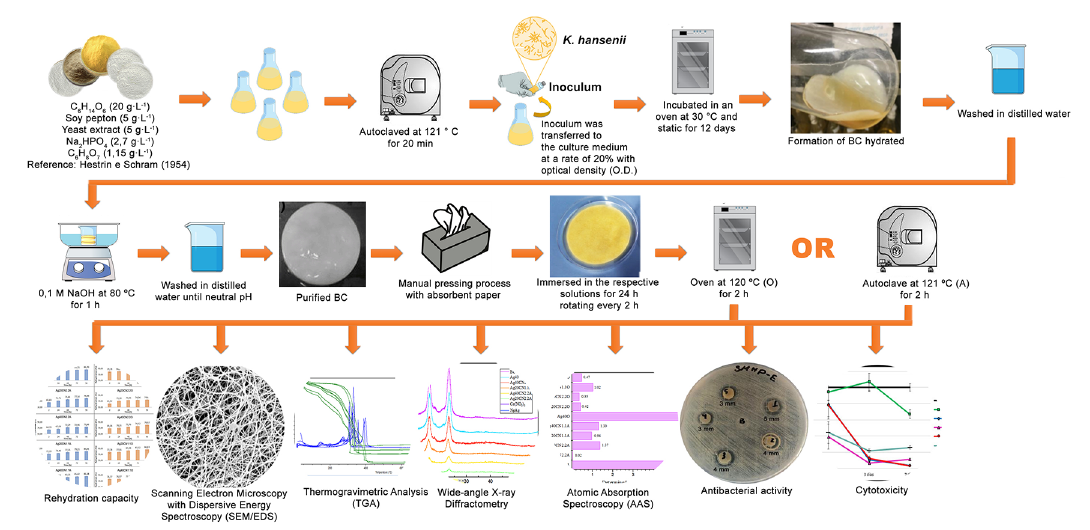
Figure 1. Schematic illustration of the synthesis of functionalized BC membranes submitted to different thermal treatments and characterization of the membranes